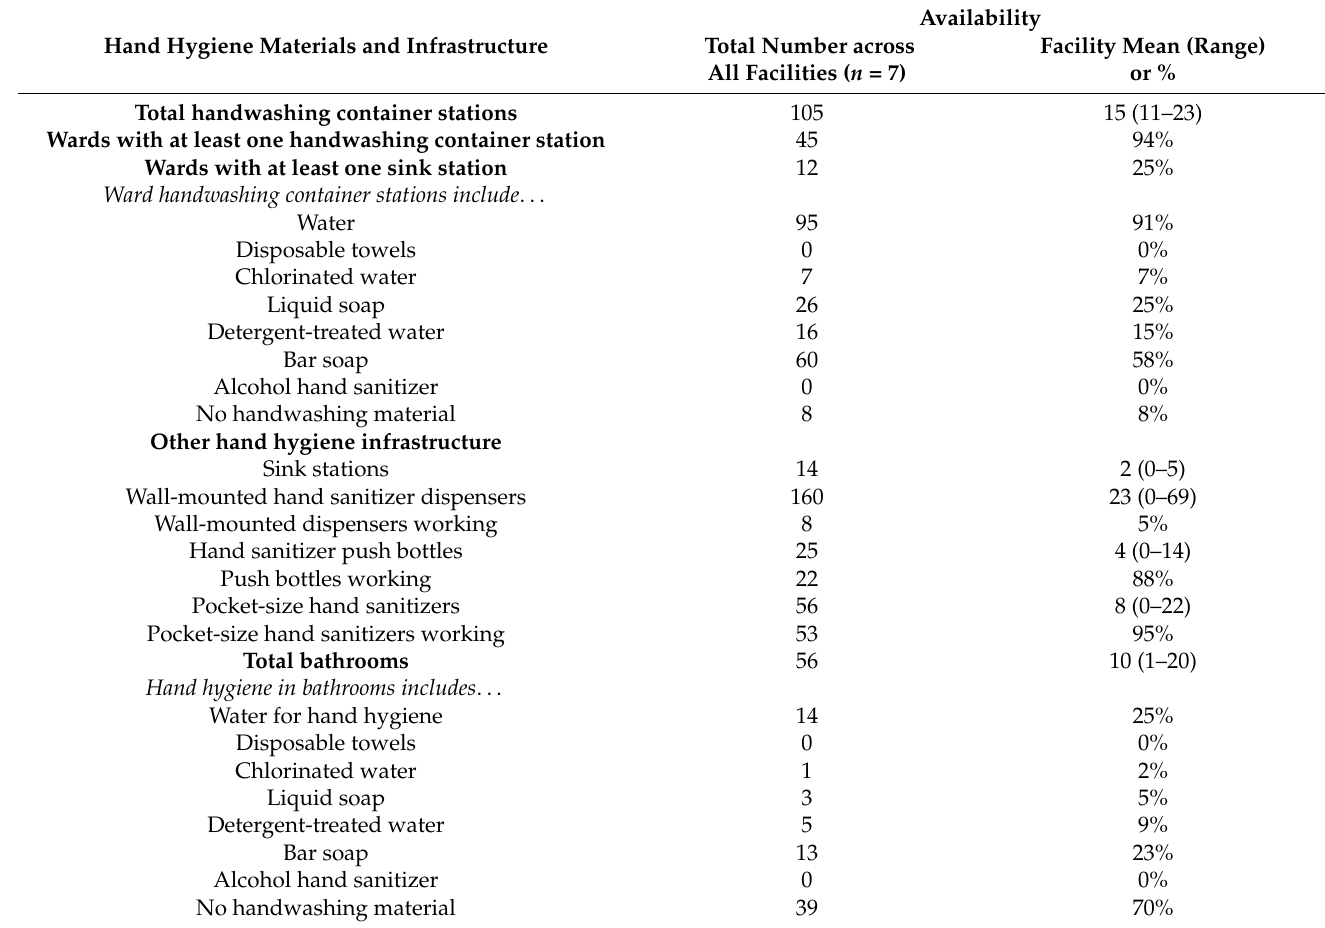
Table 1. Hand hygiene materials and infrastructure observed in 7 Liberian hospitals,